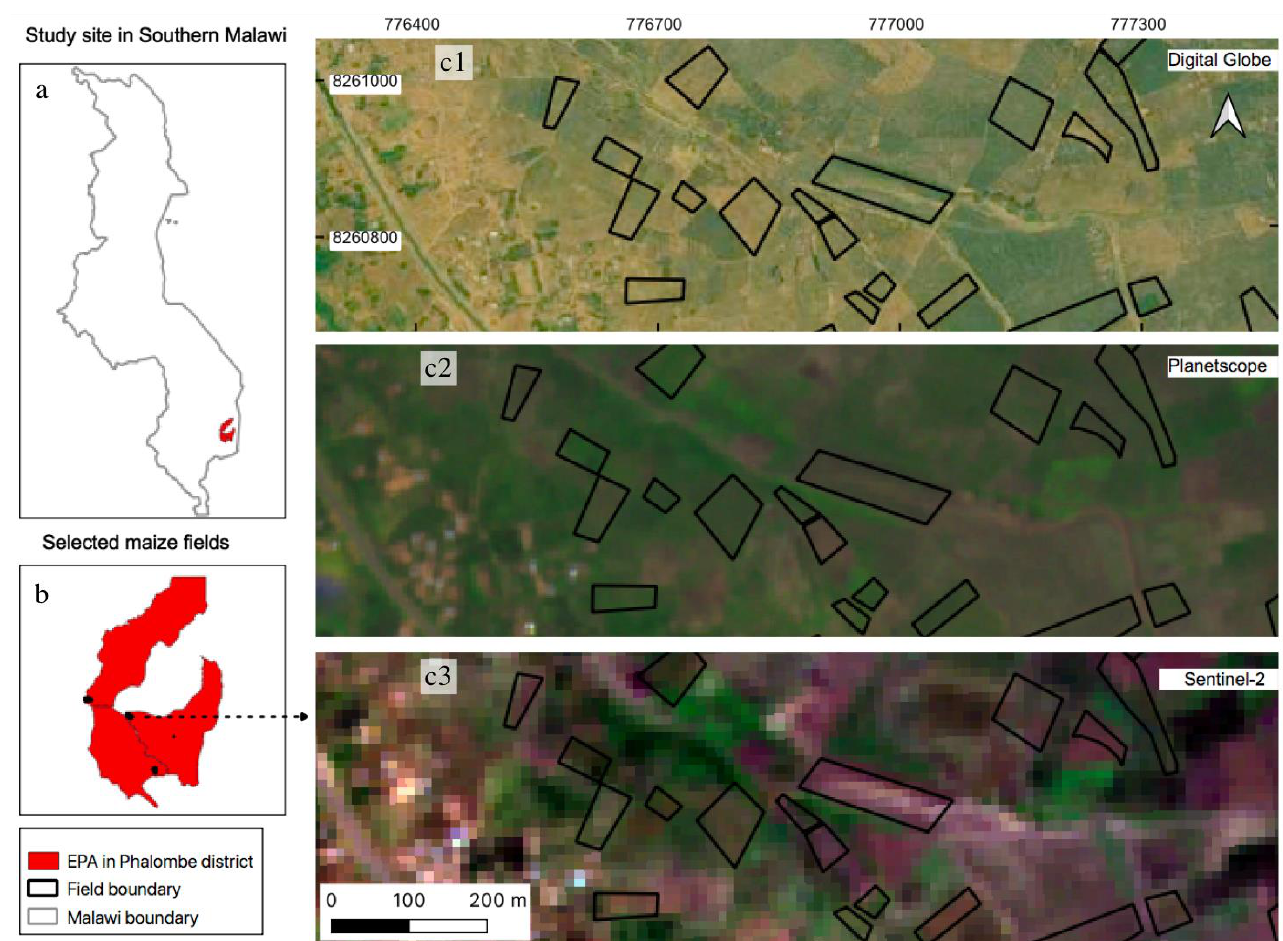
Figure 1. Location of study sites on top of multi-source satellite images; ( a ) location of study sites showing three EPAs (red polygons) in Southern Malawi; ( b ) location of investigated maize (black outlines) within the study sites; ( c1 – c3 ) examples of selected maize fields on top of different satellite imagery: ( c1 ): Digital Globe imagery (collected in 2016 © 2021 CNES/Airbus, Maxar Technologies, Westminster, CO, USA) shows maize fields at 0.5 m spatial resolution, comparing to ( c2 ) spatial resolution of 3 m PlanetScope imagery (collected on 22 February 2020) and ( c3 ) 10 m Sentinel-2 imagery (collected on 21 March 2020) used in this study.